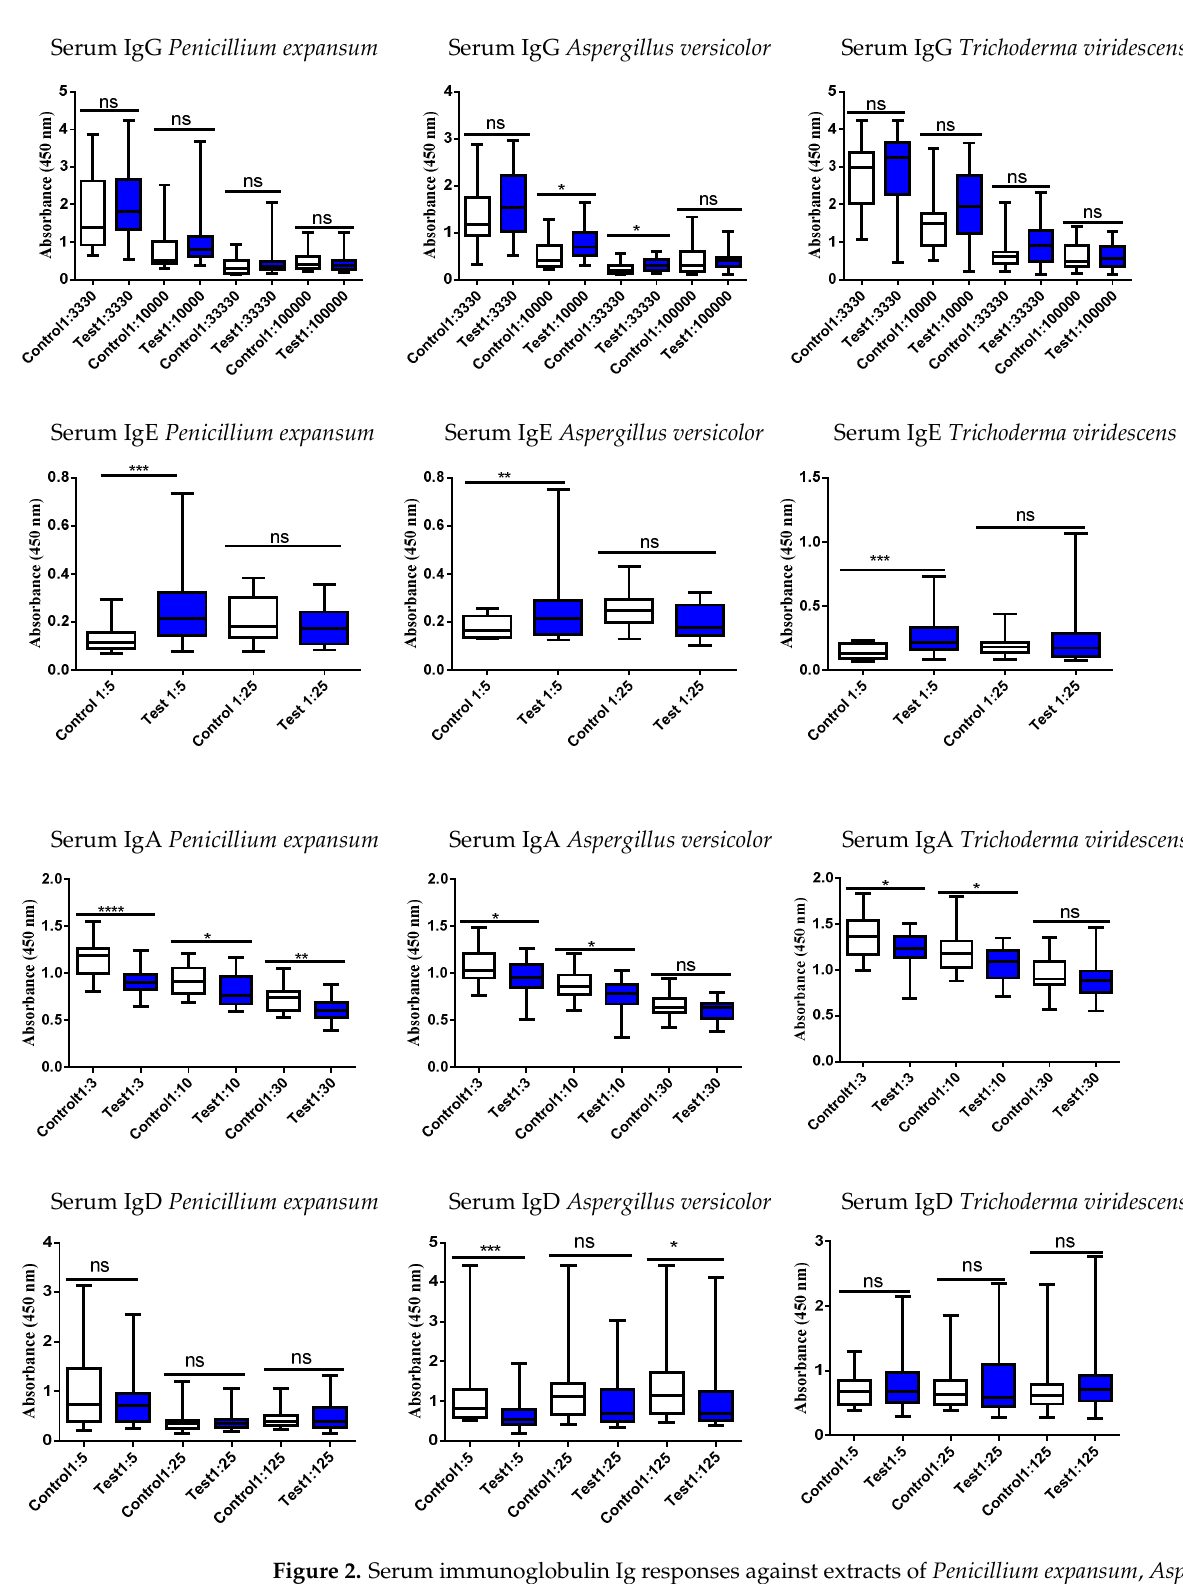
Figure 2. Serum immunoglobulin Ig responses against extracts of Penicillium expansum , Aspergillus versicolor , and Trichoderma viridescens . Boxplots indicate median values with 95% confidence intervals; statistically significant * p < 0.05, ** p < 0.01, *** p < 0.001 and **** p < 0.0001 when the study persons were compared to controls. Ns = non-significant.